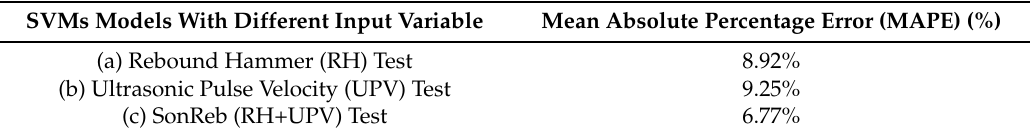
Table 1. SVMs model prediction accuracy.